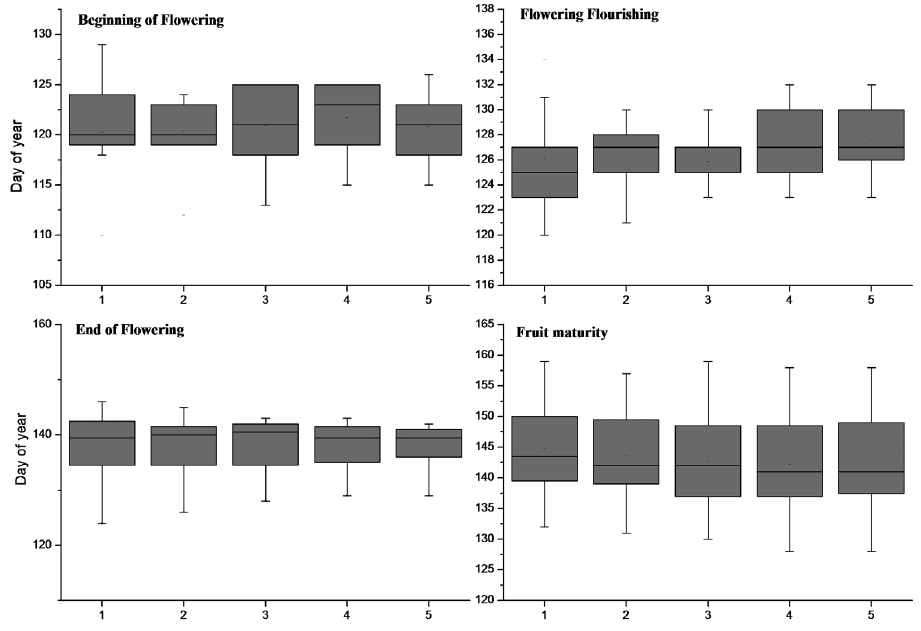
Figure 1. The phenological phases of the Calligonum mongolicum complex. 1 C. mongolicum 2 C. chinense 3 C. gobicum 4 C. pumilum and 5 C. zaidamense . Table 3. Comparison of actual fruit set of species in the Calligonum mongolicum complex under each pollination treatment in 2011 to 2013 (n = the total number of flowers manipulated in each treatment, data shown are mean ±